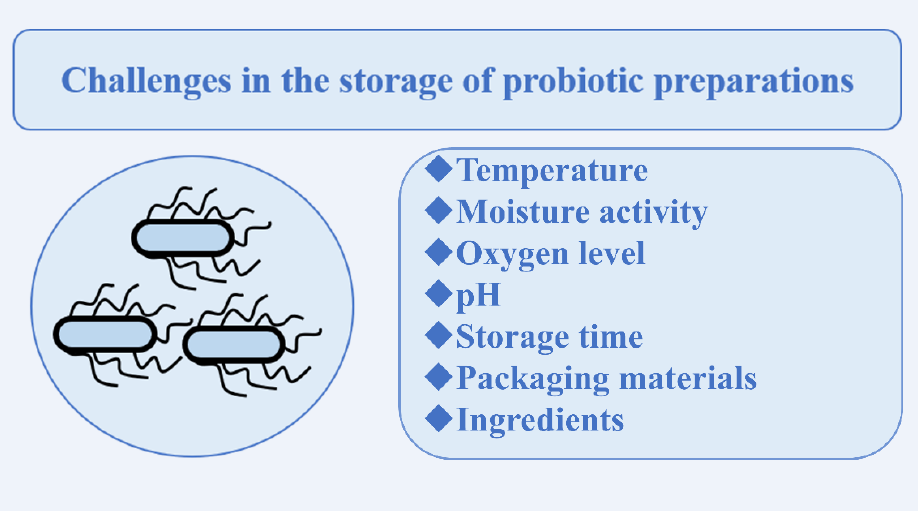
Figure 1. Factors affecting the storage stability of probiotic preparations.